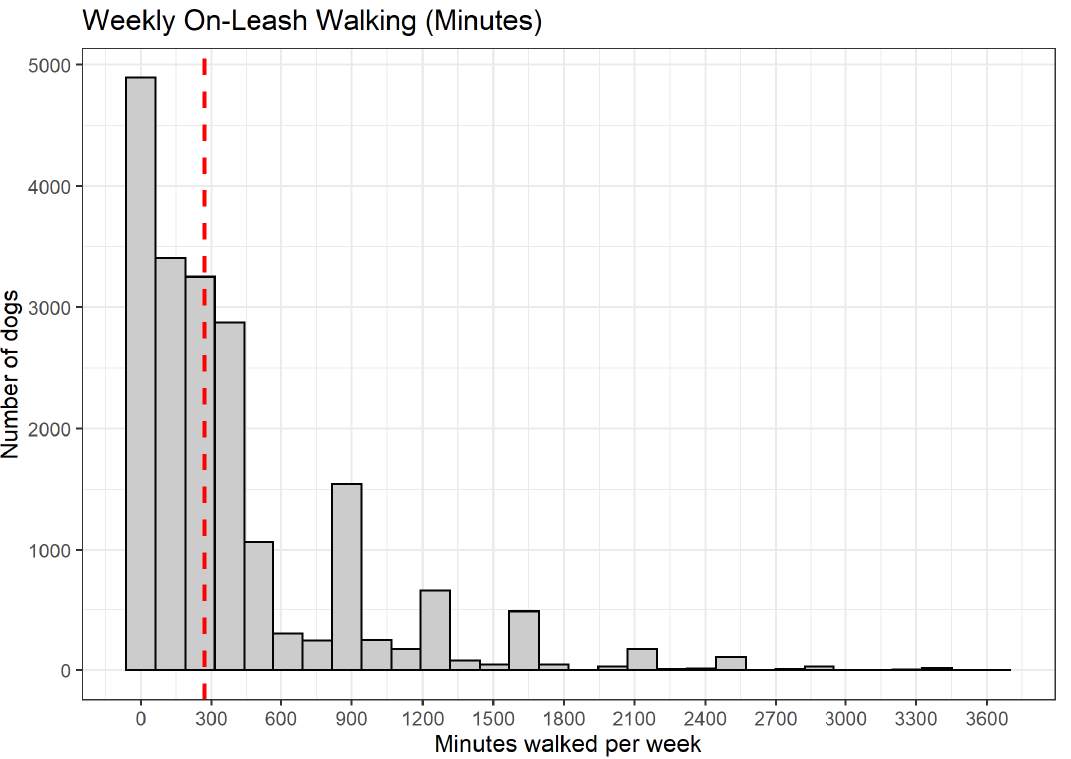
Figure 1. Histogram of Weekly On-Leash Walking Minutes. Vertical red line corresponds to median weekly walking minutes.